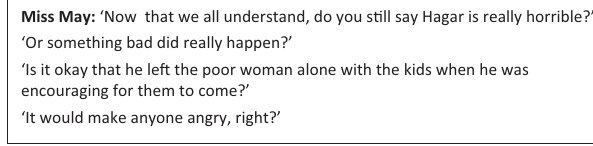
FIGURE 8: Miss May’s comment on Hagar